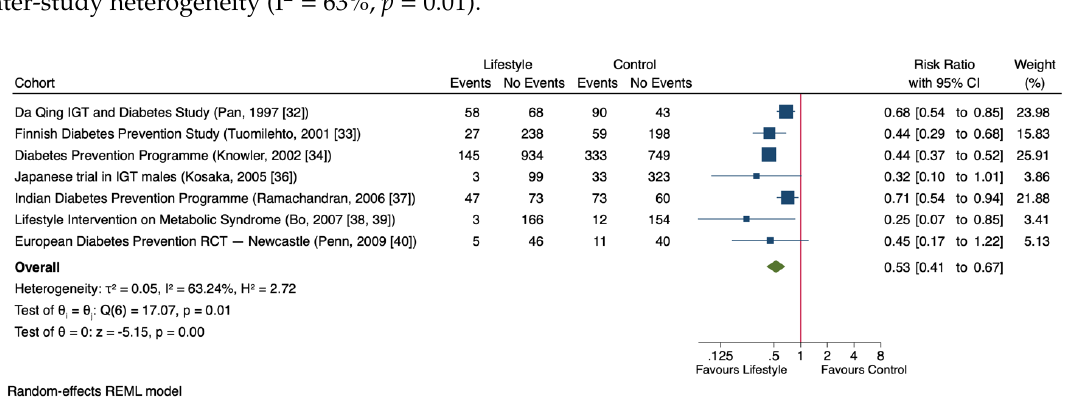
Figure 3. Forest plot of randomized controlled trials investigating the effect of lifestyle changes on type 2 diabetes risk (T2D). The pooled effect estimate for the overall effect is represented by the green diamond. Data are expressed as weighted risk ratios with 95% confidence intervals (CIs) using the restricted maximum likelihood (REML) random-effects model. Inter-study heterogeneity was tested by the Cochrane Q-statistic at a significance level of p < 0.10 and quantified by I 2 , where a level of ≥50% represented substantial heterogeneity.